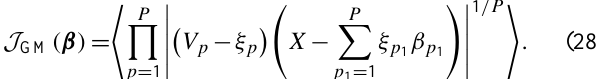
Fig. 2. The short-time mean square error (MSE) evolution for the Lorenz model with a small model error ( δr = 2 . 5 × 10 − 3 ) and with 5 × 10 5 ensembles of 500 members. The lines indicated with “1 predictor” and “4 predictors” apply to all regression methods except for GM and EREG II. The numbers indicated after GM and EREG II are the predictor numbers.